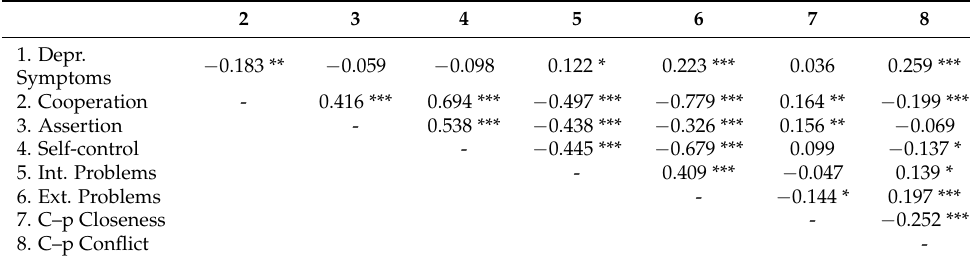
Table 2. Correlations among the study